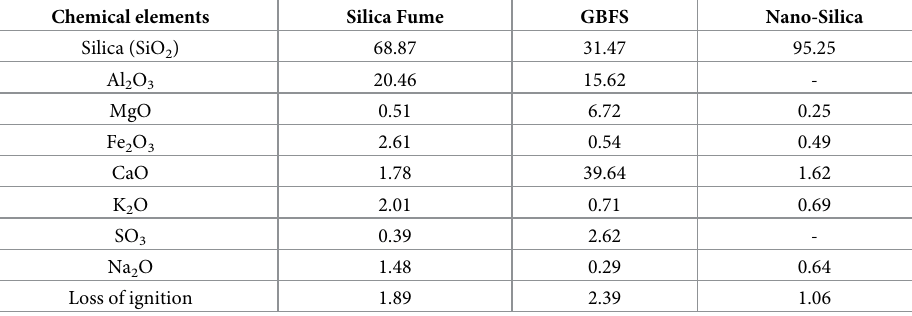
Table 2. Chemical properties of silica fume, GBFS,